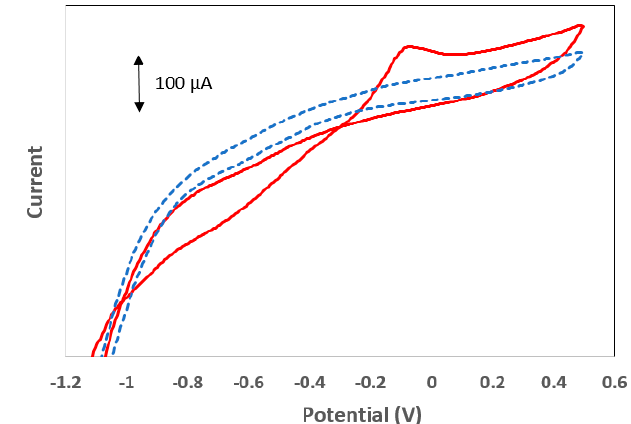
Figure 3. Cyclic voltammetry (CV) in the range from − 1.1 V to + 0.5 V preceded by an accumulation step at –1.2 V for 300 s in 0.01 mol L − 1 HCl (dotted blue line) and after the addition of 100 mg L − 1 of Sb(III) (red solid line).